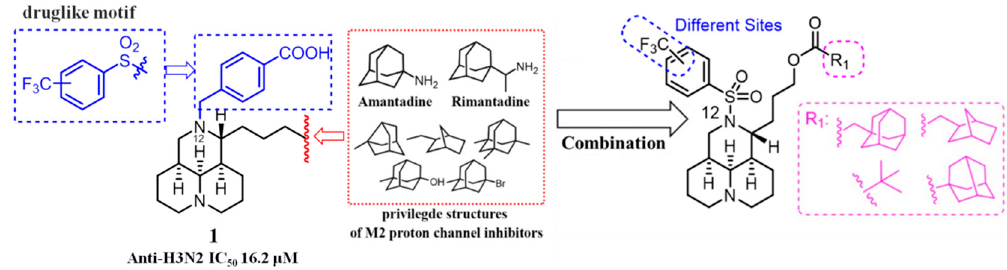
Figure 1. The strategy of structure modification.